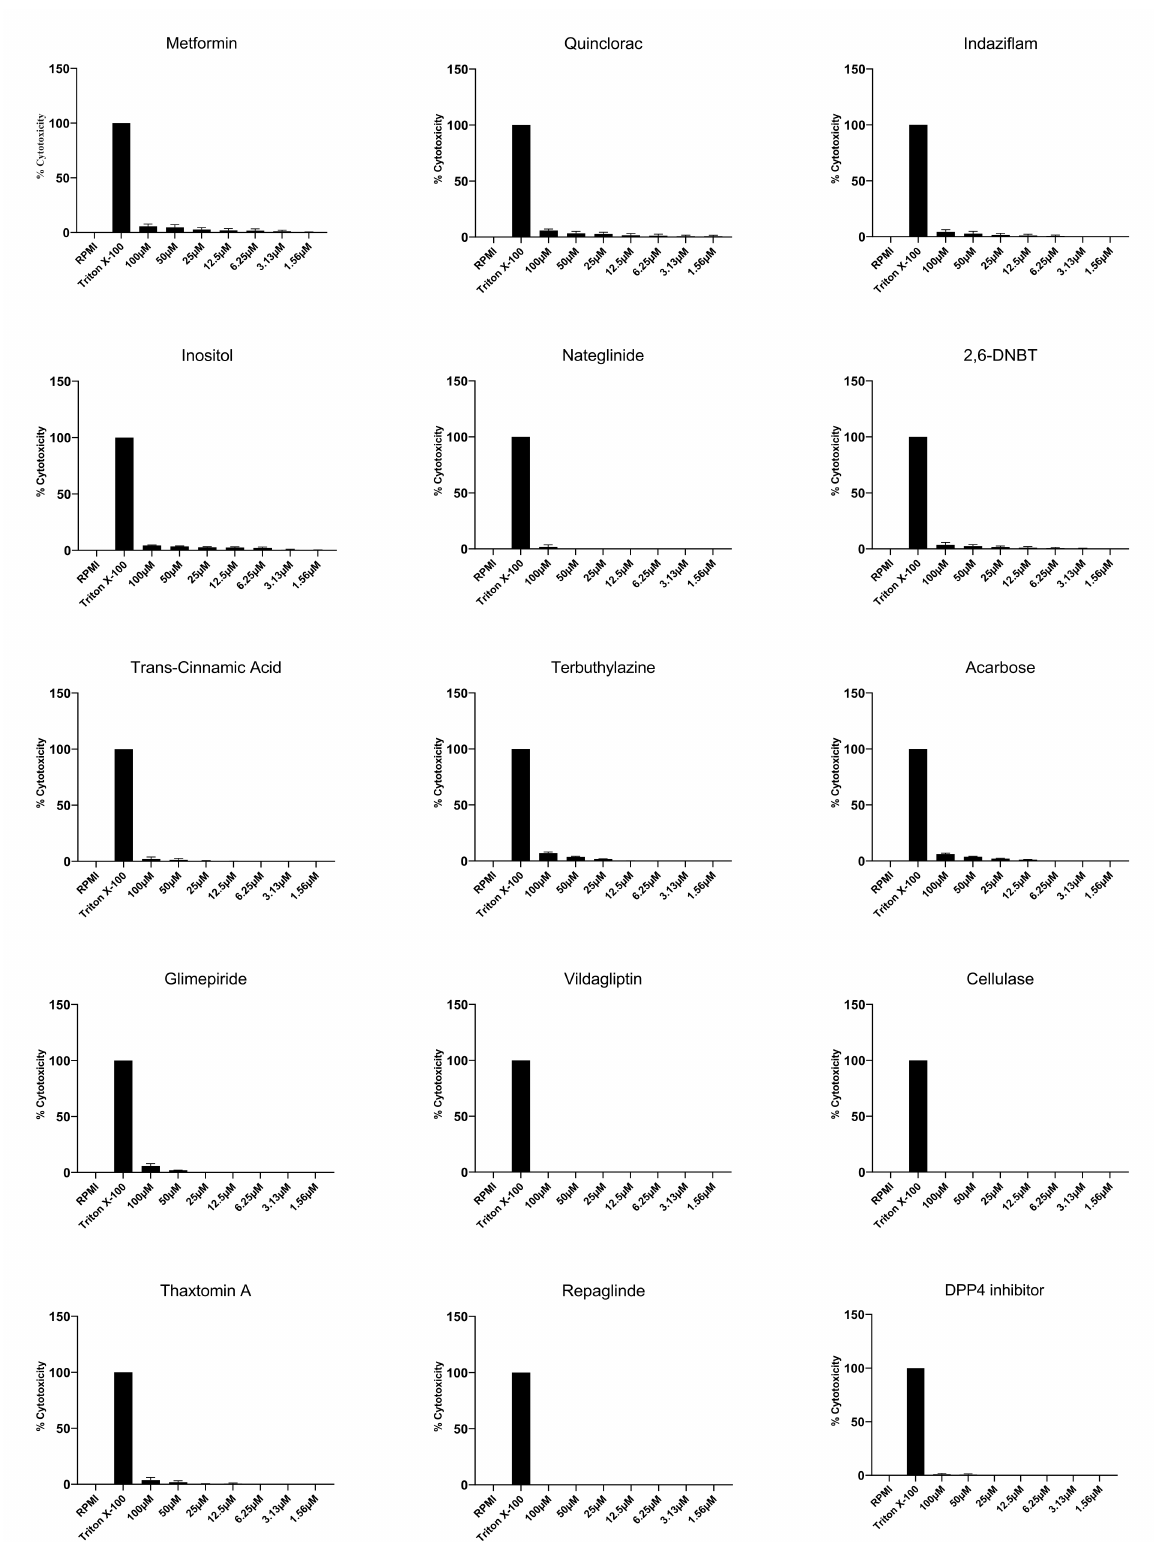
Figure 4. Cytotoxic effects of compounds against human cells are depicted. Various concentrations of compounds were incubated with human cells for 24 h at 37 ◦ C and 5% CO 2 . RPMI alone was used as negative control and triton X-100 was used as positive control. Data are presented as the mean ± standard error of 2 experiments conducted in